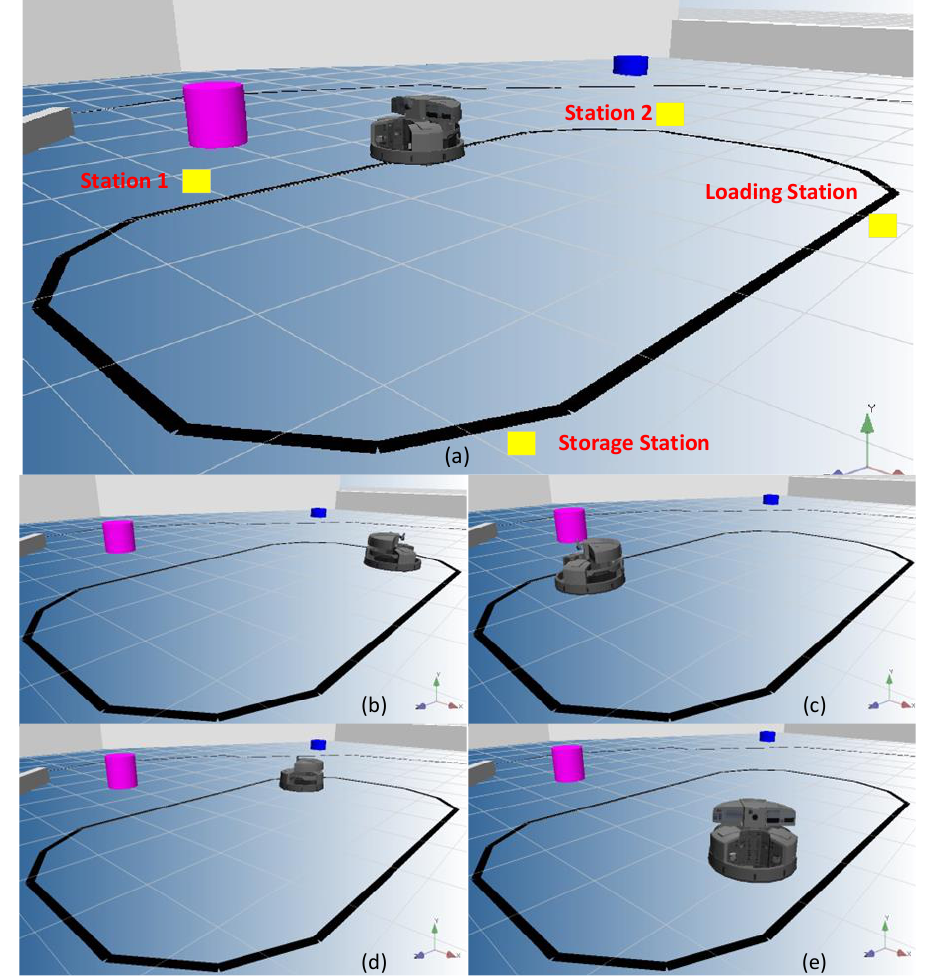
Figure 8. ( a ) Locations determined in the simulation. ( b ) The mobile robot is located at the loading station. ( c ) The mobile robot is located at station 1. ( d ) The mobile robot is located at station 2. ( e ) The mobile robot is located at the storage station.